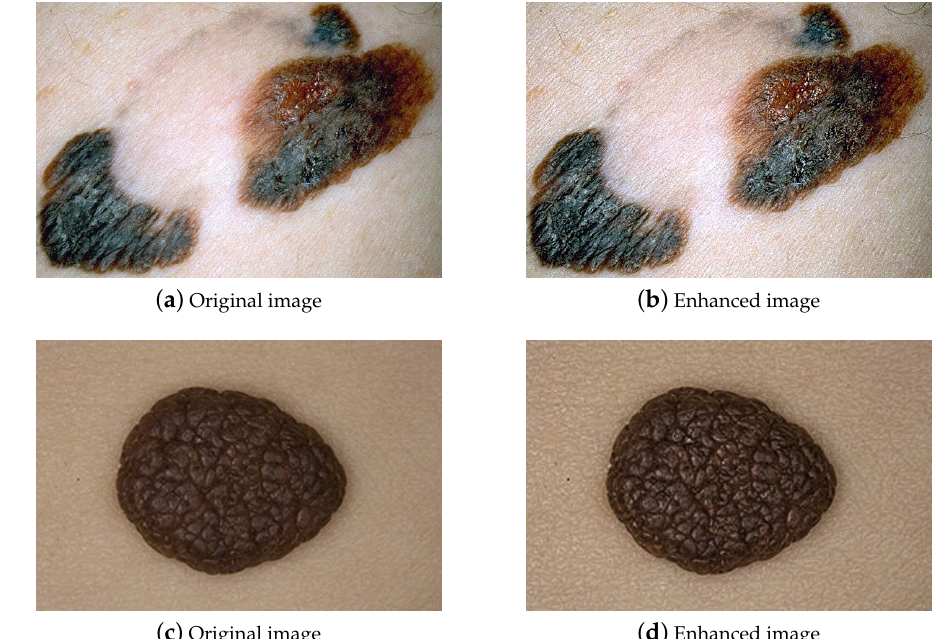
Figure 1. Dermoscopy images. Visual results obtained by MGRTH with n = 3 and ω =